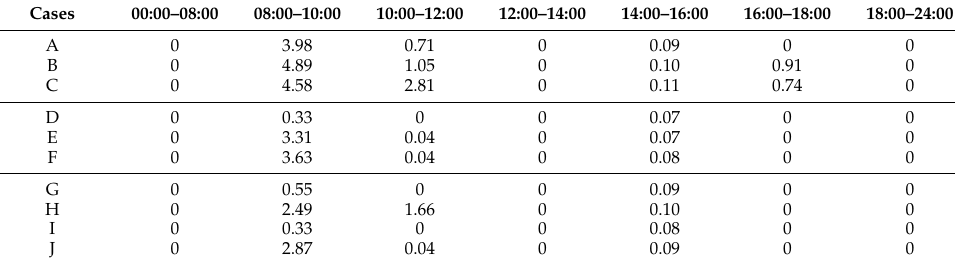
Table 4. Cold uncomfortable hours in each case studied.